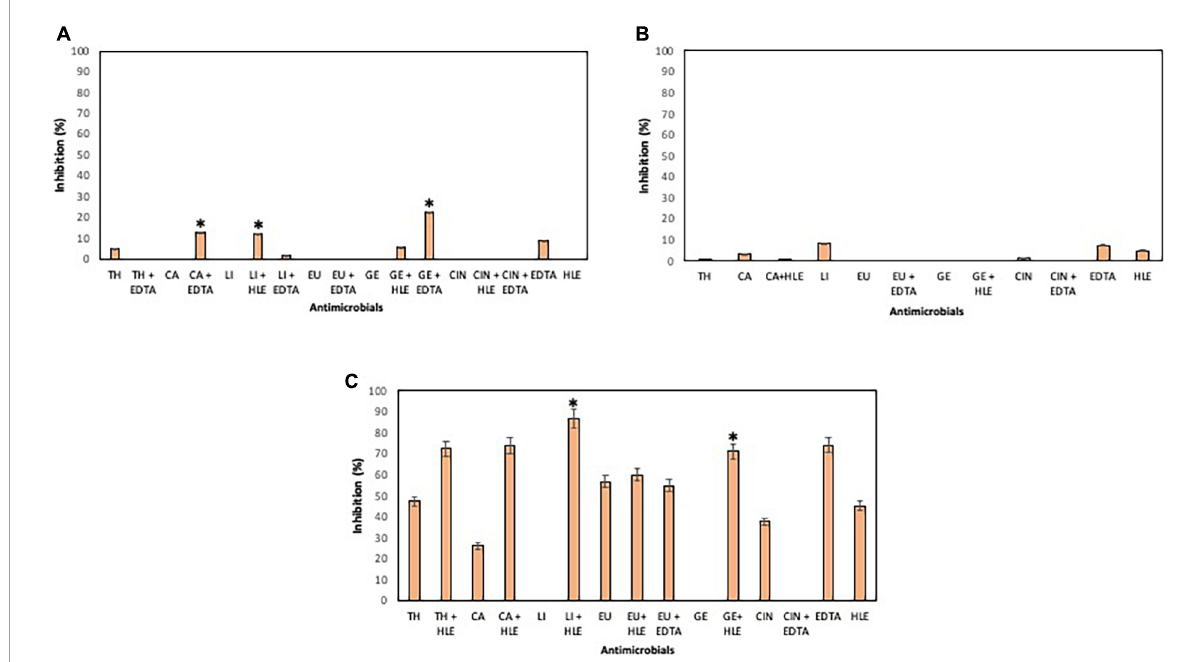
FIGURE4 Inhibition of biofilm formation of Pseudomonas sp. strains M13K11 (A) , M22K12 (B) and M33T02.2 (C) in the presence of EOCs (TH, CA, LI, EU, GE and CIN), EDTA, HLE or their synergistic combinations at MIC and sub-MIC (0.5 or 0.25) concentrations. Data were expressed as mean value ( ± standard deviations). *Indicate a statistically significant synergistic effect of antimicrobials.